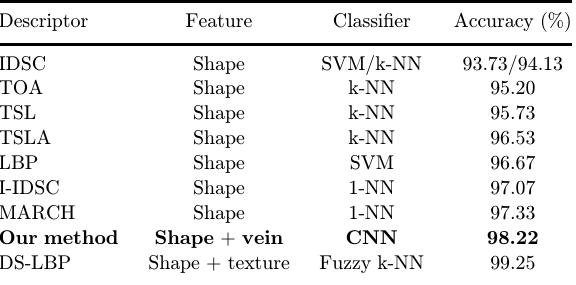
Table 4. Comparison of results of leaves recognition methods on the Swedish data